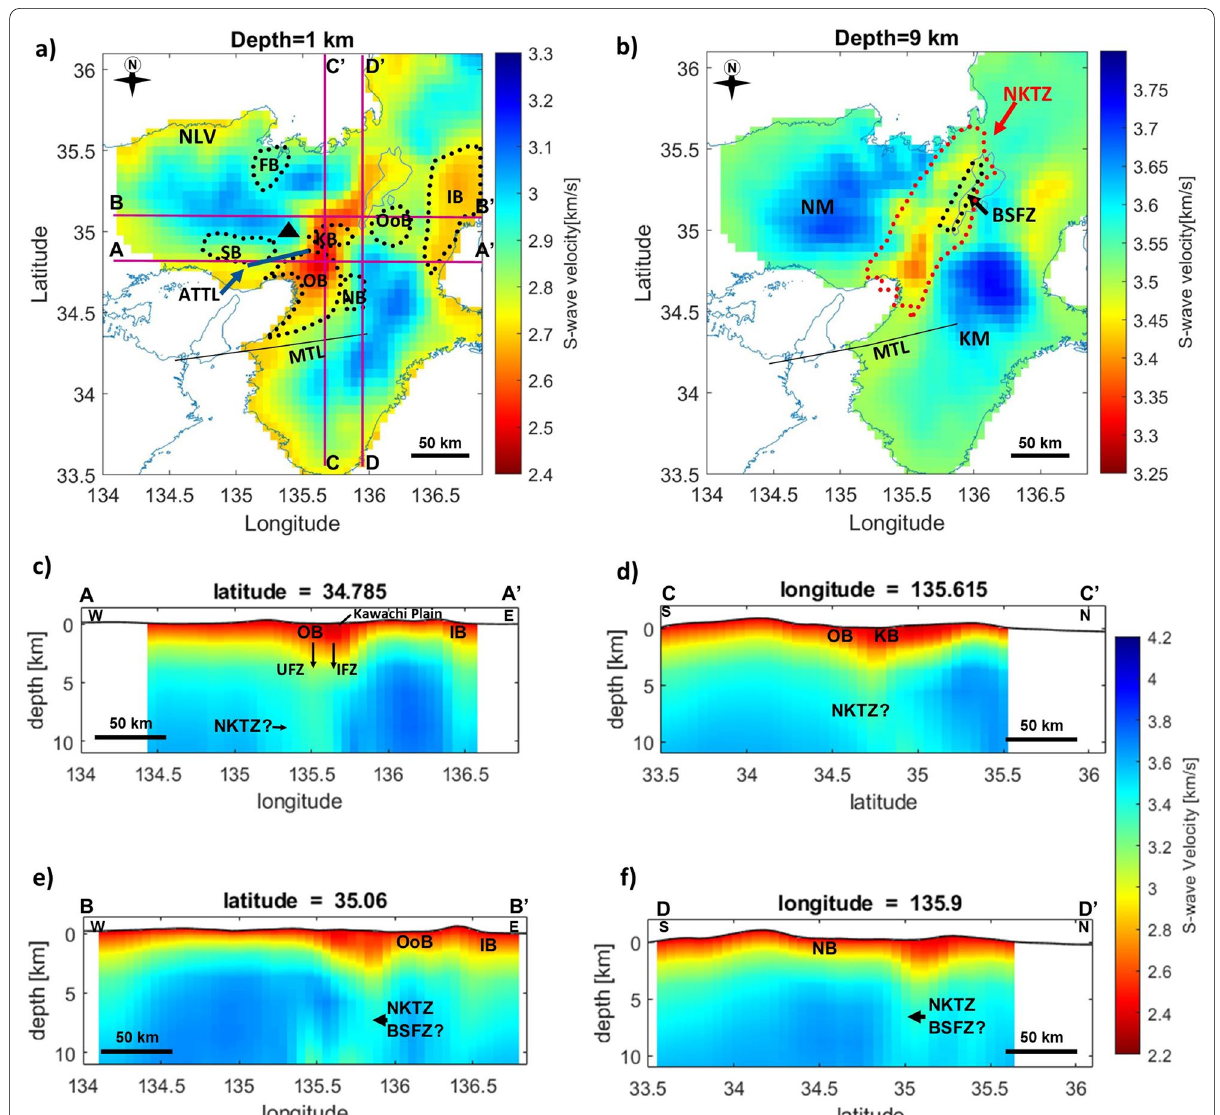
The solid black line represents the Median Tectonic Line (MTL), the dashed red closed-curve represents the Niigata–Kobe Tectonic Zone (NKTZ), and the thick solid blue line indicates the location of the Arima-Takatsuki Tectonic Line (ATTL). Black triangle represents the location of Hokusetsu mountains. Thin, dashed black closed-curves show the locations of major sedimentary basins (SB, Sanda basin; FB, Fukuchiyama basin; OB, Osaka basin; NB, Nara basin; OoB, Oomi basin; KB, Kyoto basin; and IB, Ise basin). Also shown on the depth slices are the probable locations of the Kawachi plain, Nara basin (NB), Uemachi Fault Zone (UFZ), Ikoma Fault Zone (IFZ), Biwako-seigan Fault Zone (BSFZ), NKTZ, Osaka basin (OB), and Ise basin